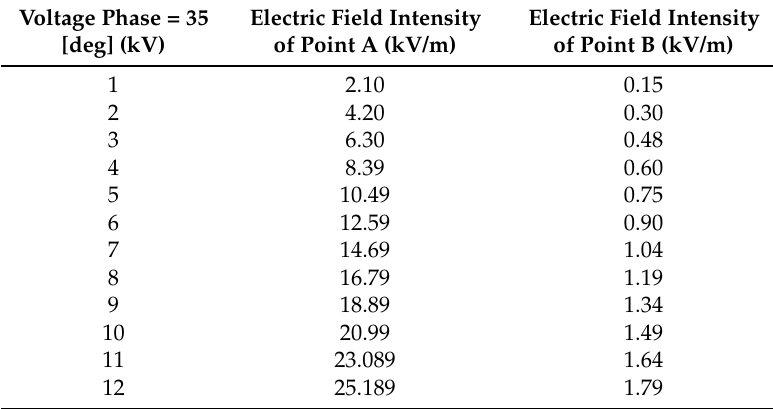
Table 3. Electric field intensity at A and B when sensor is not used.